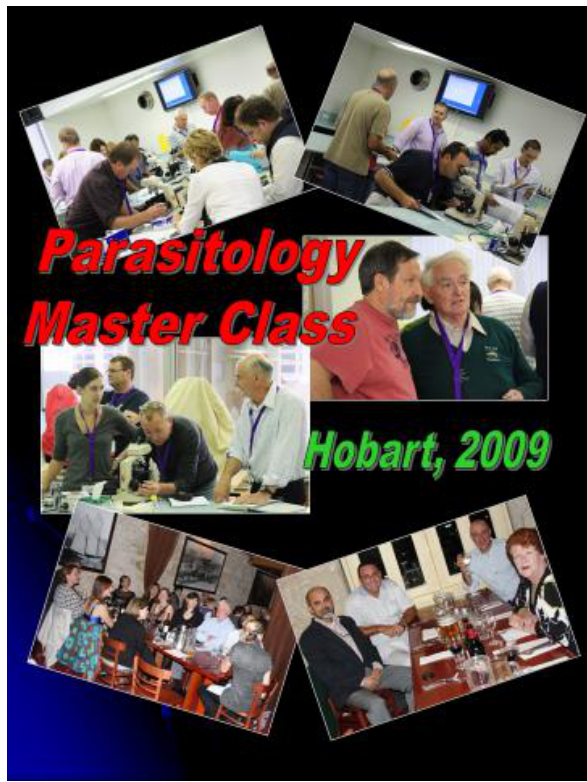
Figure 1. The inaugural Australian parasitology master class.